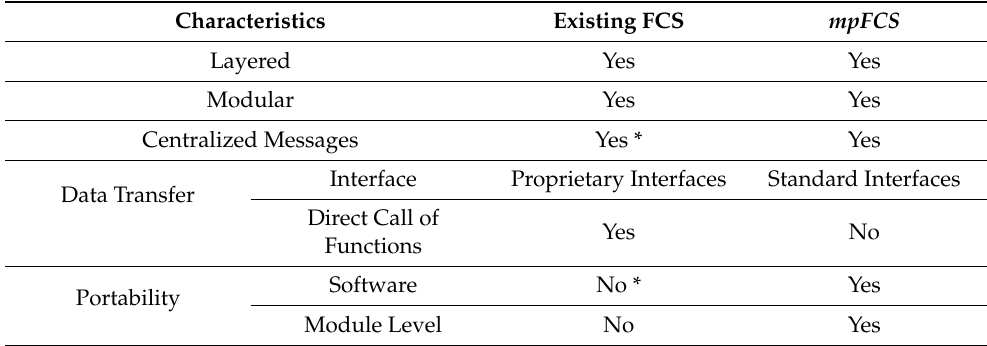
Table 3. Comparison of the existing FCS and the mpFCS